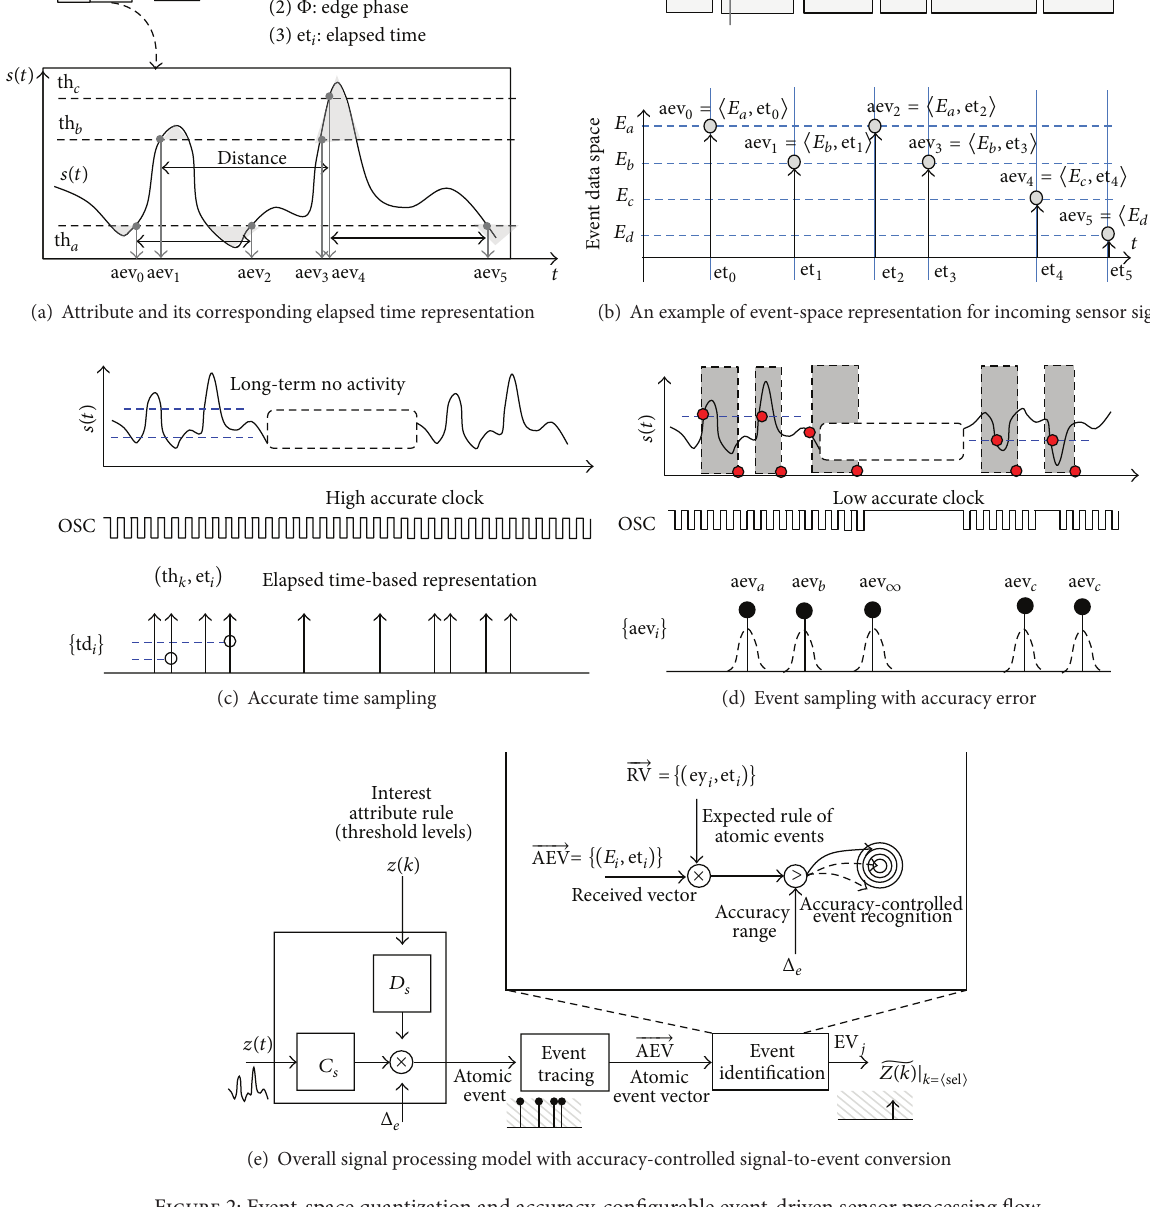
the time distance relationship between the atomic events. The traced event vector identifies the approximate result final event by comparing it to the expected rules of the atomic